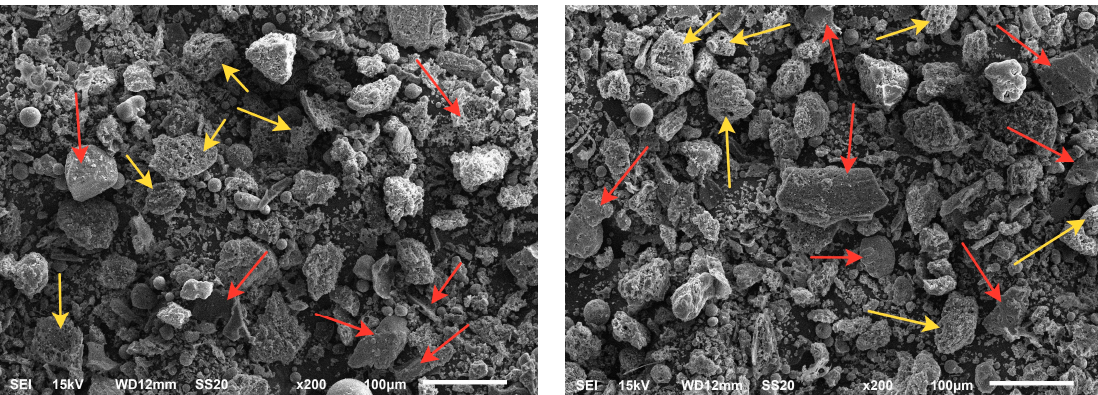
Figure 8. The SEM images of unburned carbon particles obtained by flotation of the CFA non-magnetic fraction (the collector volume is 3 mL); yellow arrows show porous spherical particle; red arrows show non-hollow elongated rectangular particle.